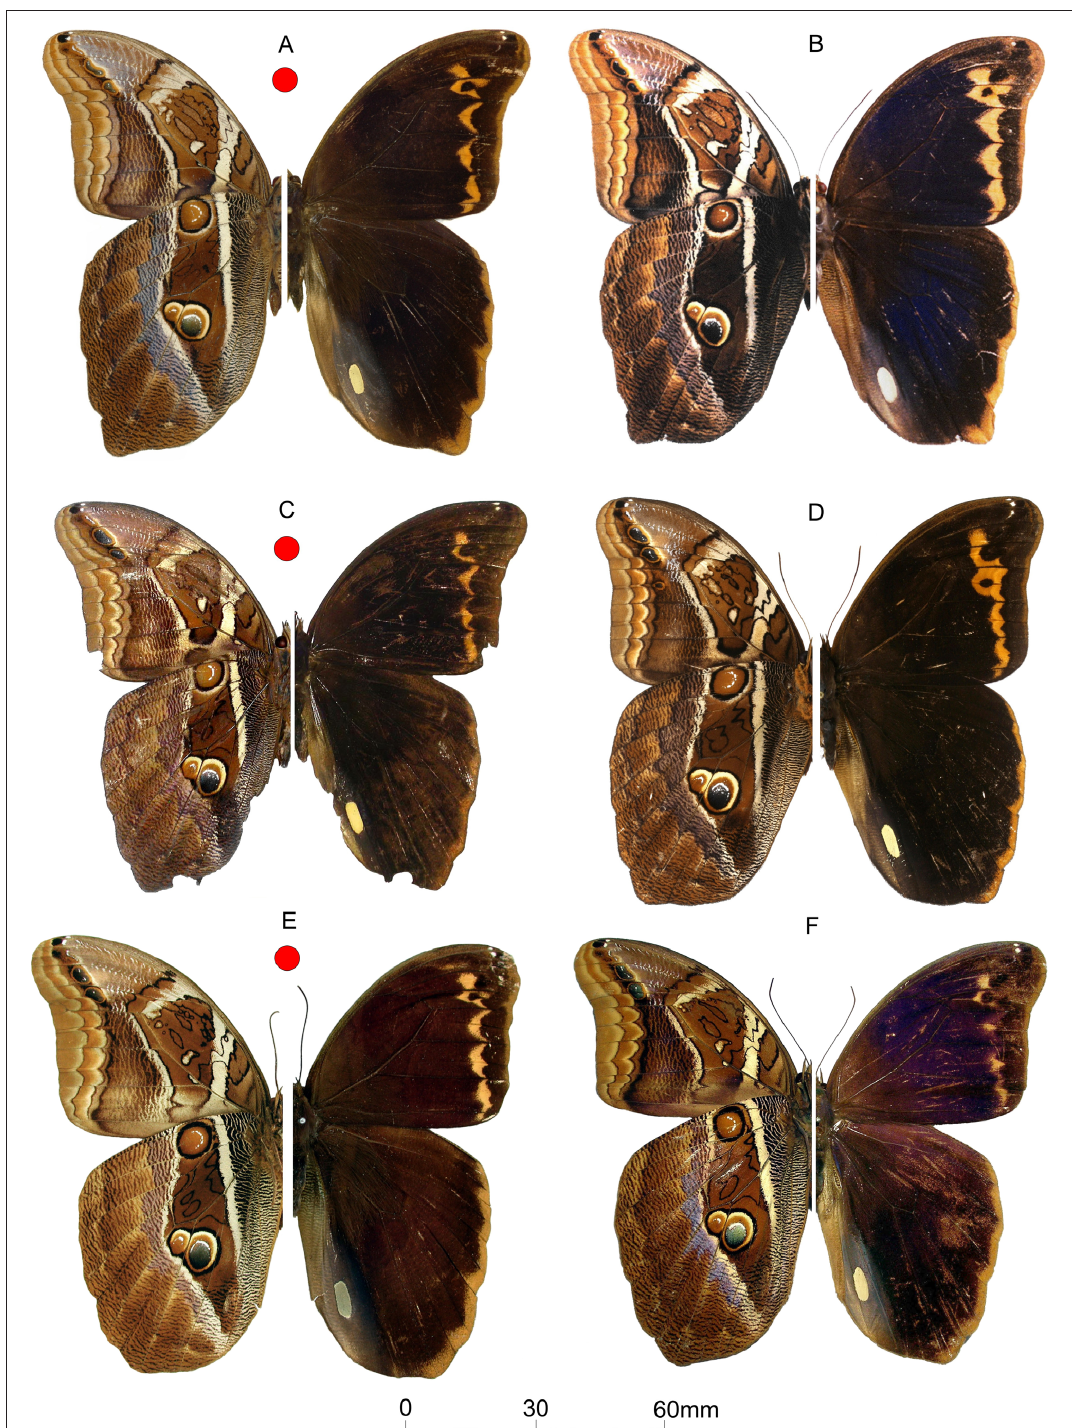
Fig. 5. Habitus of males. Red spot: holotype (HT) or lectotype (LT). A . Eryphanis zolvizora greeneyi Penz & DeVries, 2008, stat. rev., HT (Yanayacu, Napo, Ecuador; BMNH). B . E. z. greeneyi , specimen with increased forewing spots (Baeza, Napo, Ecuador, Pinas). C . Eryphanis zolvizora casagrande ssp. nov., HT (Altaquer, Nariño, Colombia; ICNUN). D . E. z. casagrande from Western Ecuador (Las Gralarias, Pichincha; FLMNH). E . Eryphanis zolvizora opimus (Staudinger, 1887), LT (Manizales, Colombia; ZMHB). F . E. z. opimus , specimen with reduced spots (Cauca, Colombia; MNHN,